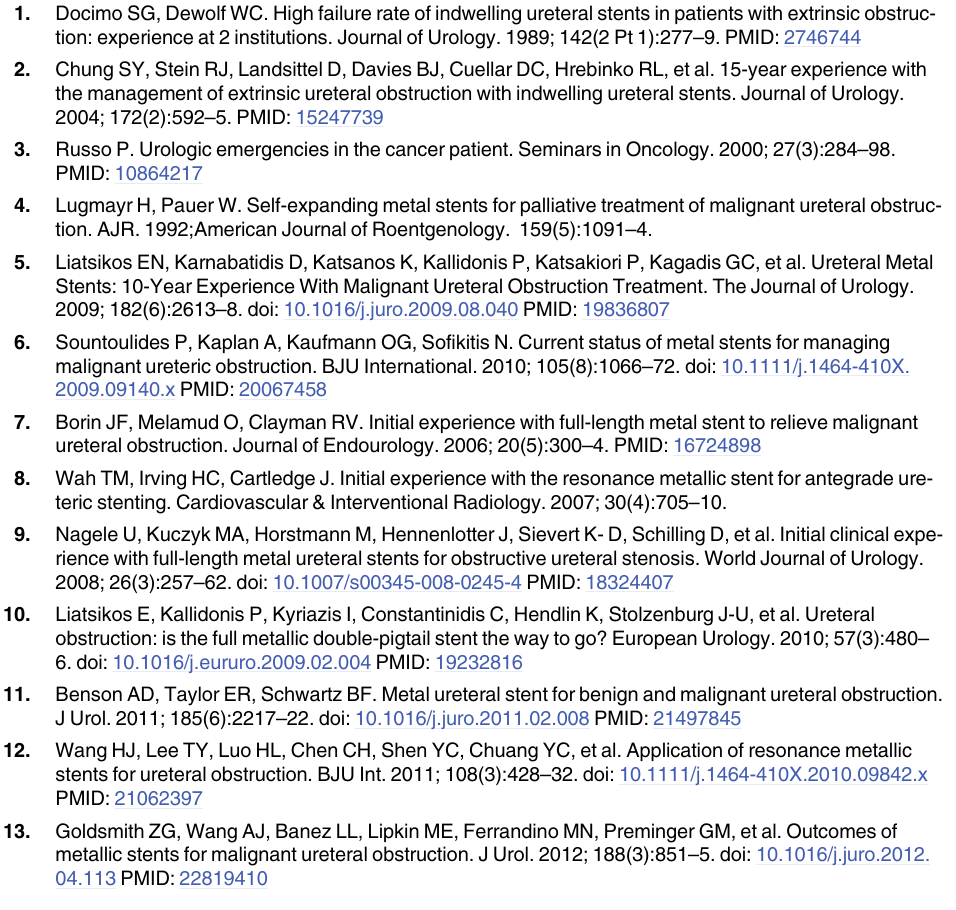
S1 Table. Duration difference of each stent. Dura diff: duration difference